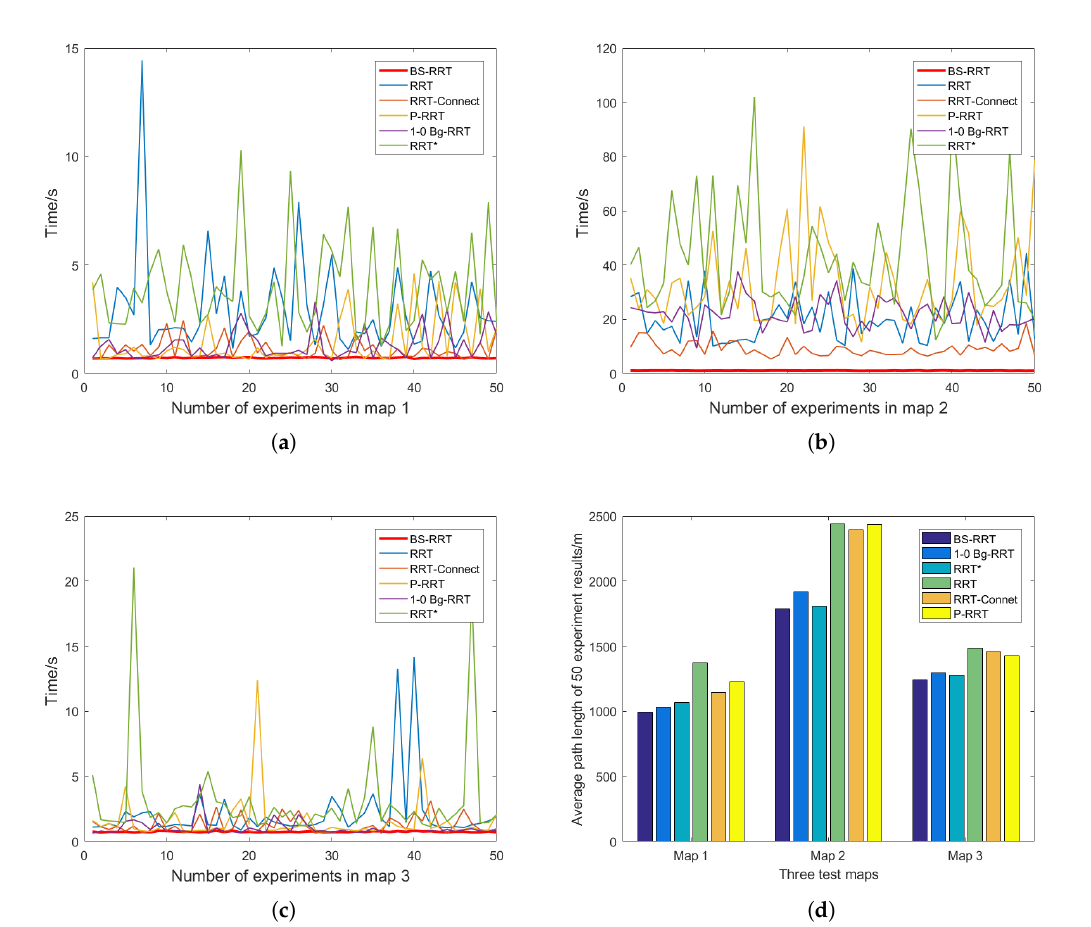
Figure 11. ( a – c ) show the run time for each of the 50 experiments for BS-RRT, RRT, RRT-Connect, P-RRT, 1-0 Bg-RRT, and RRT ∗ in the three maps; ( d ) shows the average path length of 50 experiments using the six